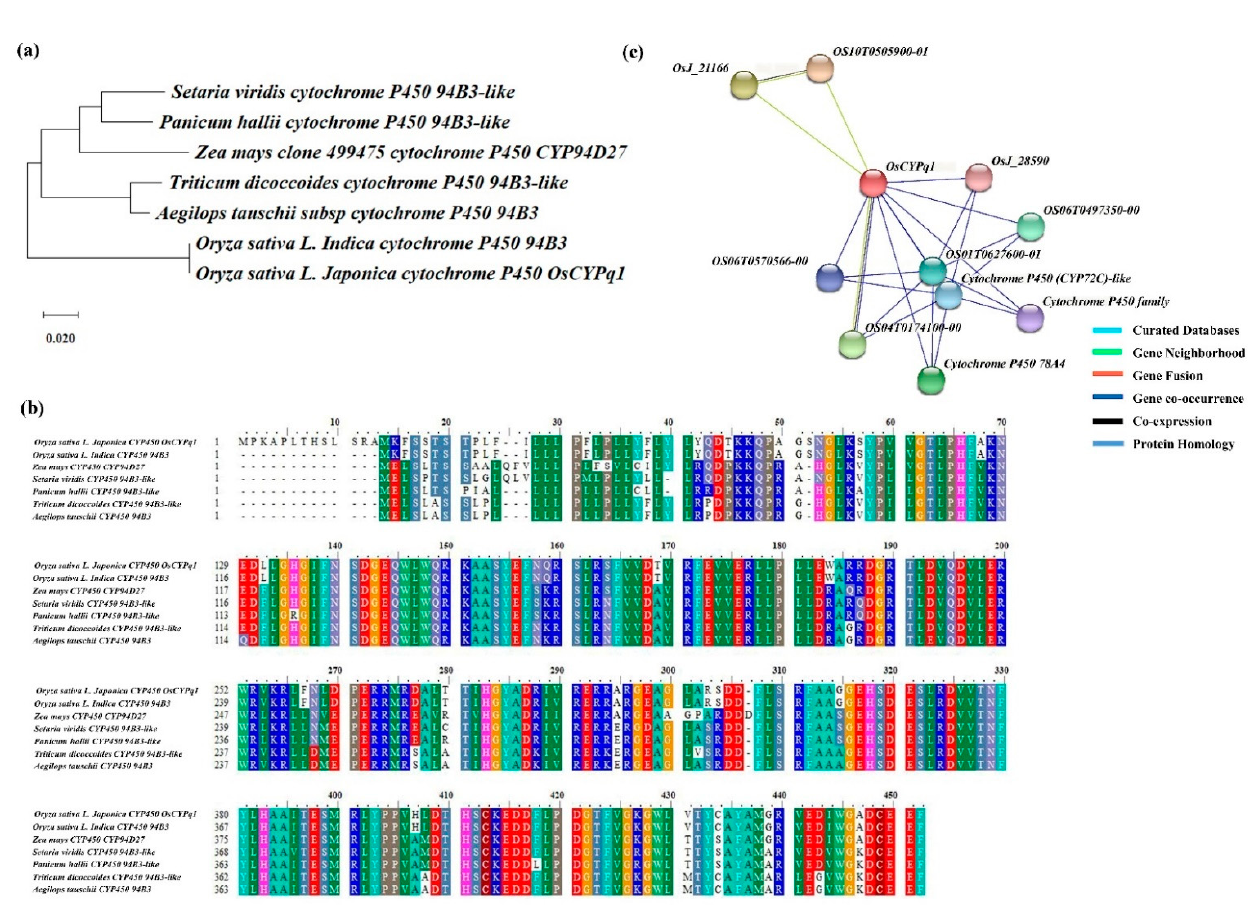
Figure 5. Sequence analysis of OsCYPq1 . ( a ) The gene and homology genes were analyzed by a phylogenetic tree. The parsimony method with 1000 bootstrap replicates was used for constructing the phylogenetic tree. ( b ) Comparing the multiple sequence alignment of OsCYPq1 , high similarity was found among Oryza sativa L., Aegilops tauschii , Triticum dicoccoides , Zea mays , Panicum hallii , and Setaria viridis . ( c ) OsCYPq1 interacts with Cytochrome P450 family proteins. These are all involved in the GA synthesis pathway.